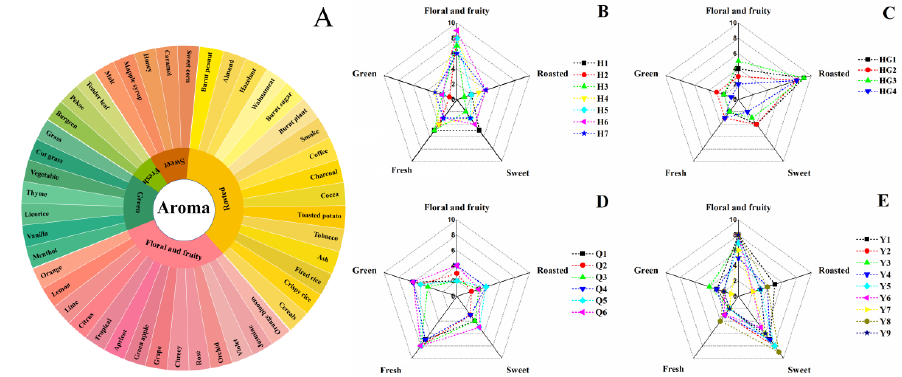
Figure 1. Flavor wheel of yellow tea ( A ) and radar of sensory aroma notes profile among the